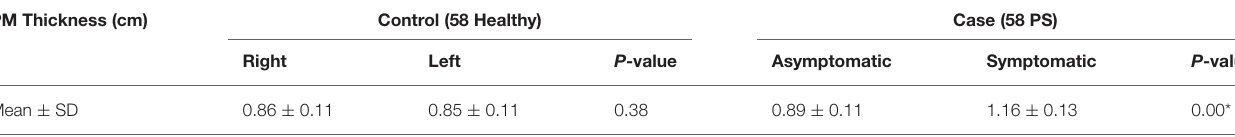
TABLE 2 | Mean and standard deviations of the PM